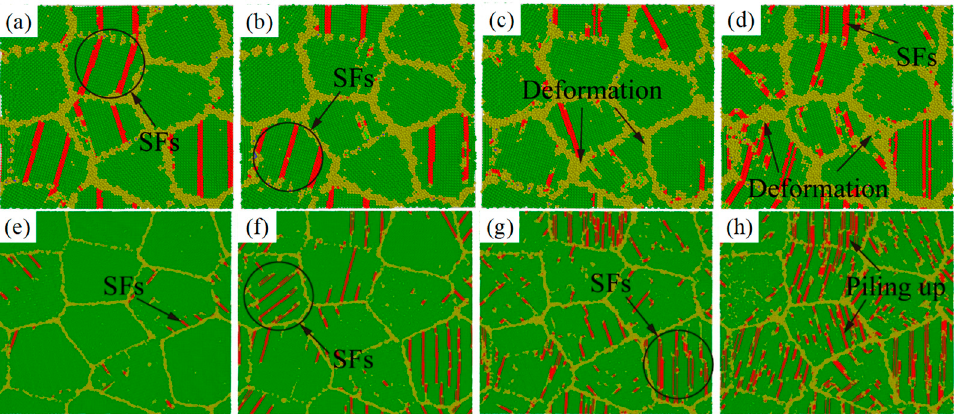
Figure 18. ( a – d ) The atomic configurations of the sample with grain size d = 7.0 nm at ε = 11% under different strain rates loading. ( a ) 5 × 10 8 s − 1 , ( b ) 10 9 s − 1 , ( c ) 5 × 10 9 s − 1 , ( d ) 10 10 s − 1 . ( e – h ) The atomic configurations of the sample with grain size d = 16.0 nm at ε = 11% under various strain rates loading. ( e ) 5 × 10 8 s − 1 , ( f ) 10 9 s − 1 , ( g ) 5 × 10 9 s − 1 , ( h ) 10 10 s − 1